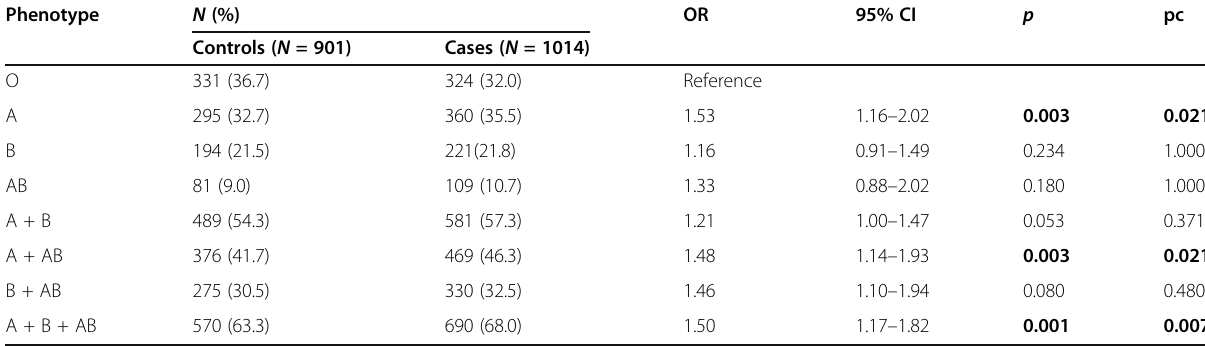
Table 1 ABO blood group distributions in COVID-19 cases and